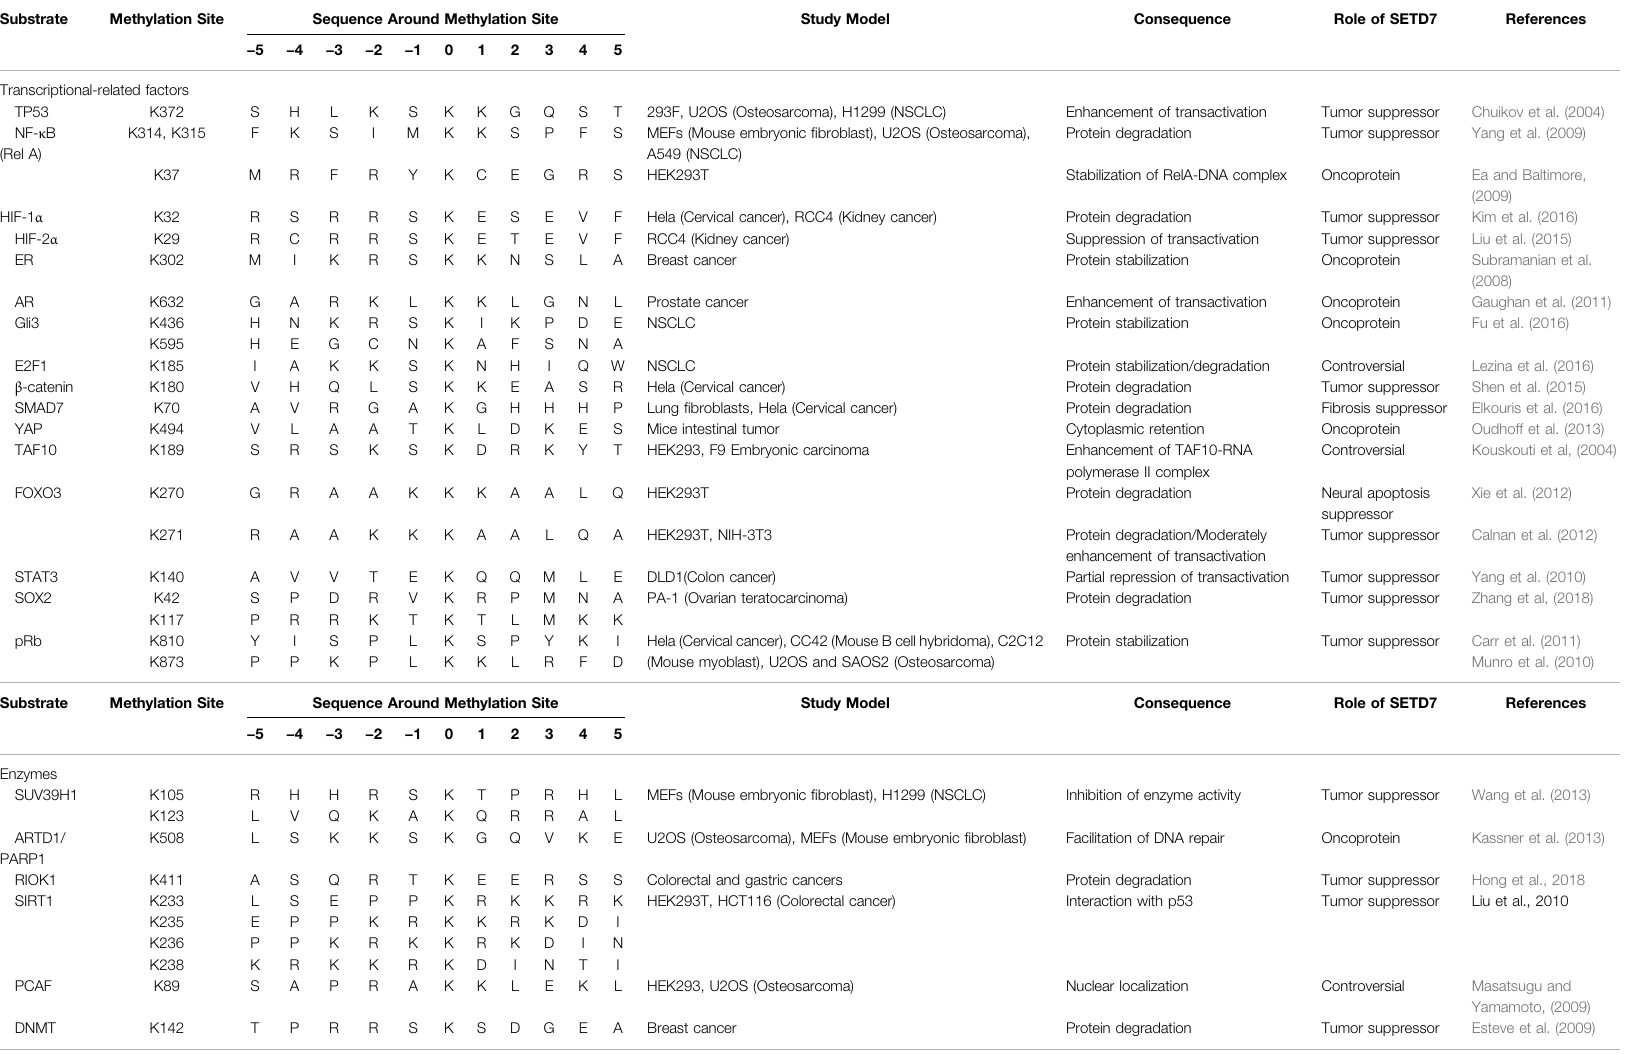
TABLE 1 | SETD7-regulated proteins and methylation sites.